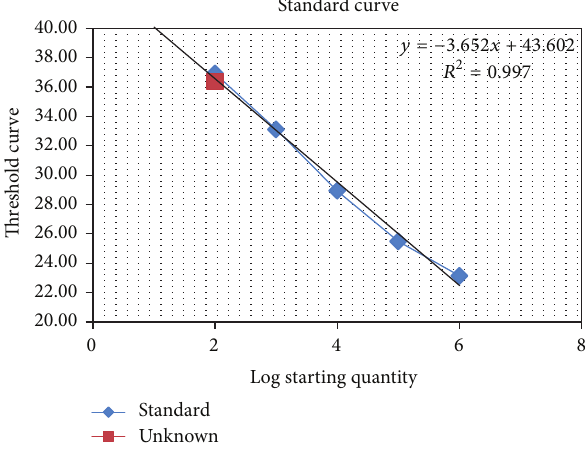
Figure 1: Standard curve obtained with qPCR on serial dilutions of Leishmania DNA (Log Starting Quantity) ranging from 10 to 10 7 parasites per reaction, with signal of the positive sample (unknown: red square)